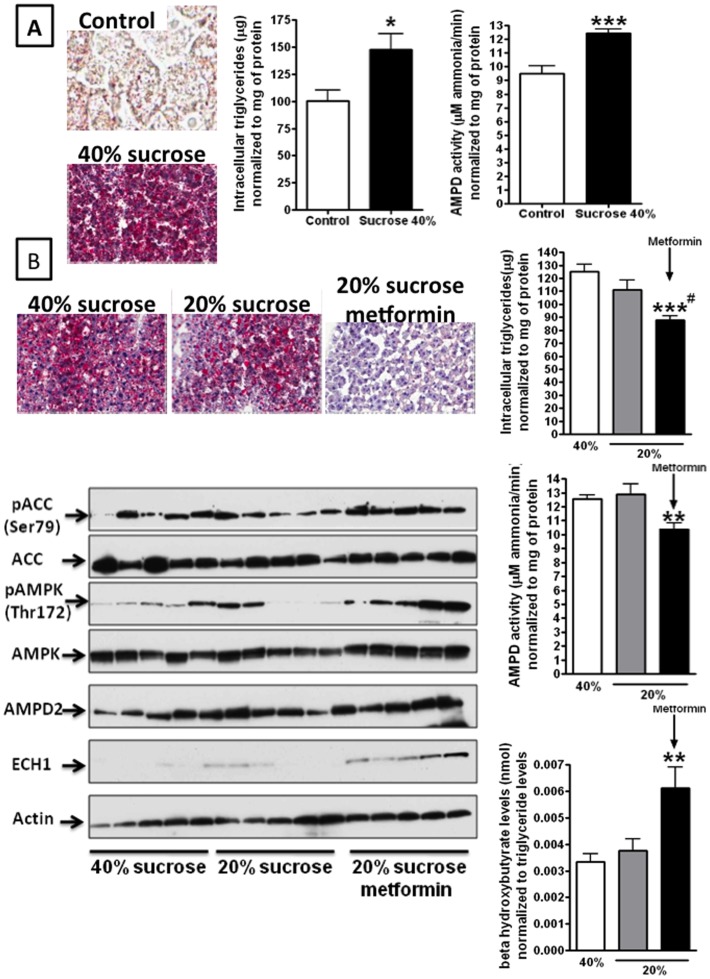
Metformin inhibits AMPD2 activity in vivo and reduces fatty liver in sucrose-fed rats.A–C) Rats fed with a 40% sucrose diet for 10 weeks develop fatty liver as determined by oil red-O staining and hepatic triglyceride determination. Activity of AMPD2 is significantly up-regulated in the livers of sucrose fed rats as compared to control rats. *p<0.05 versus control, *p<0.001 versus control. D–G) After 10 weeks, rats were maintained for more 4 weeks with a 40% sucrose diet or reduced to 20% alone or in combination with metformin (30 mg/kg). Reducing dietary sucrose to 20% does not significantly reduces fatty liver, AMPD2 activity or hepatic β- hydroxybutyrate levels. In contrast, metformin significantly reduces AMPD2 activity in the liver which is paralleled with reduction in liver fat accumulation and increase in production of β- hydroxybutyrate levels. H) Representative western blot depicting that treatment with metformin results in phosphorylation of AMPK at thr172, and with up-regulation of ECH1 levels **p<0.01 versus sucrose 40% and 20%, ***p<0.001 versus sucrose 40% and 20%, #p<0.01 versus sucrose 20%.